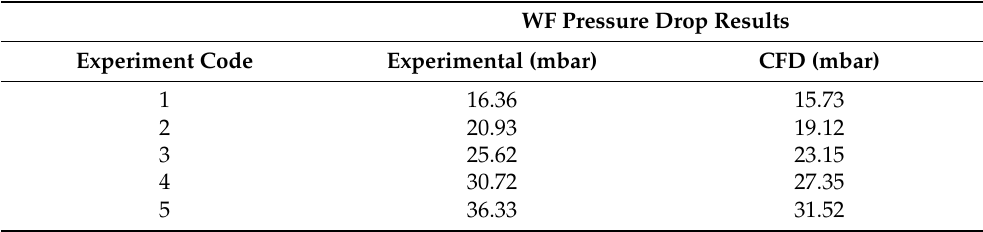
Table 3. Experimental results for WF pressure drop shown in Table 1 with the CFD